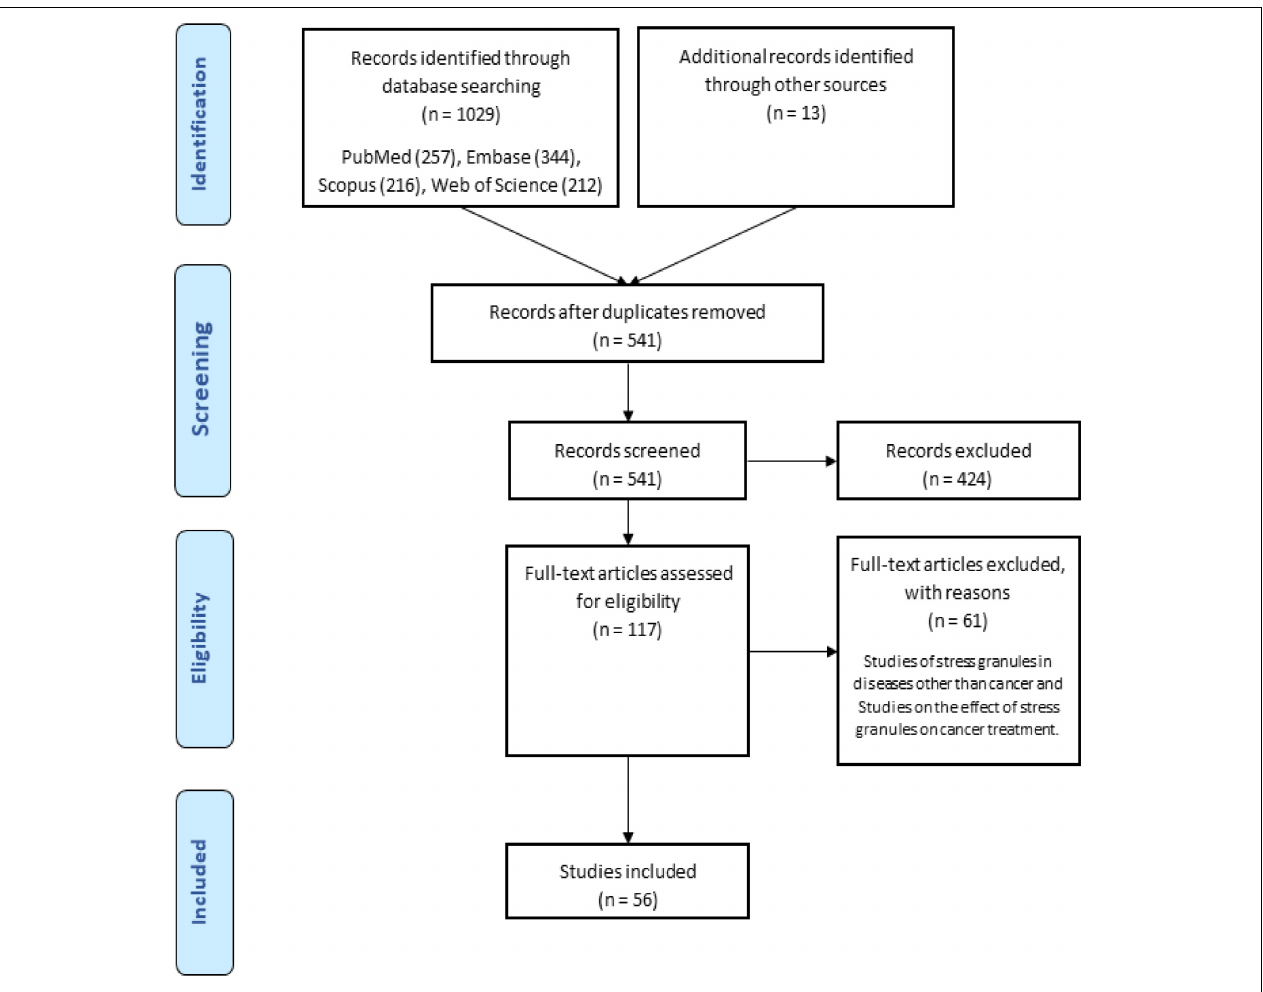
FIGURE 1 | Flow chart of search strategy based on PRISMA flow